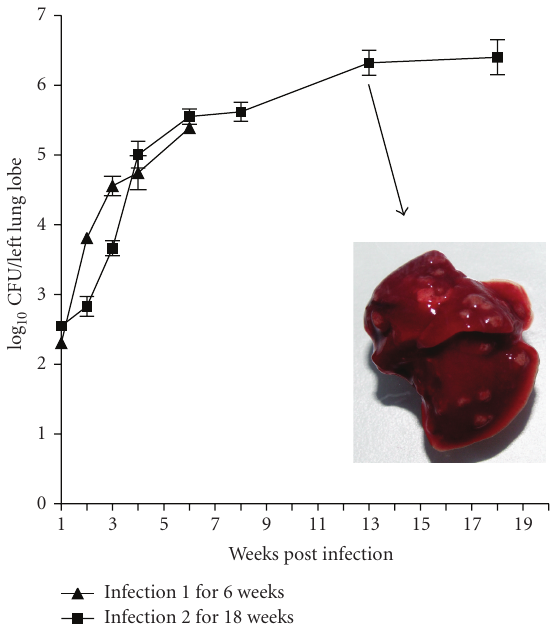
Figure 2: Course of infection of M. tuberculosis H37Rv in Rat lungs following low-grade aerosol infection. ( (cid:2) ): Course of infection and CFU obtained during weeks 1–7 in study 1. ( (cid:3) ): Course of infection and CFU obtained over weeks 2–18 in study 2. Drug treatment started at week 4 postinfection. Inset shows a rat lung at thirteen- week post infection with multiple macroscopic nodular granulomas all the lung lobes following aerosol infection with M.